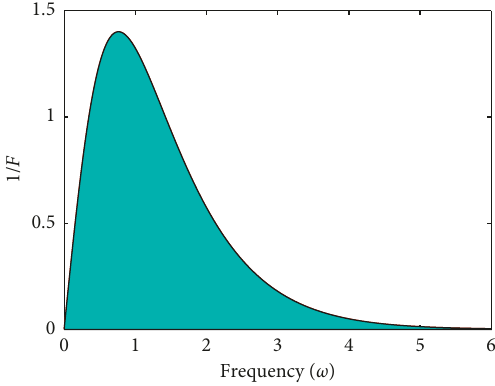
Figure 3: Chaotic threshold curve.